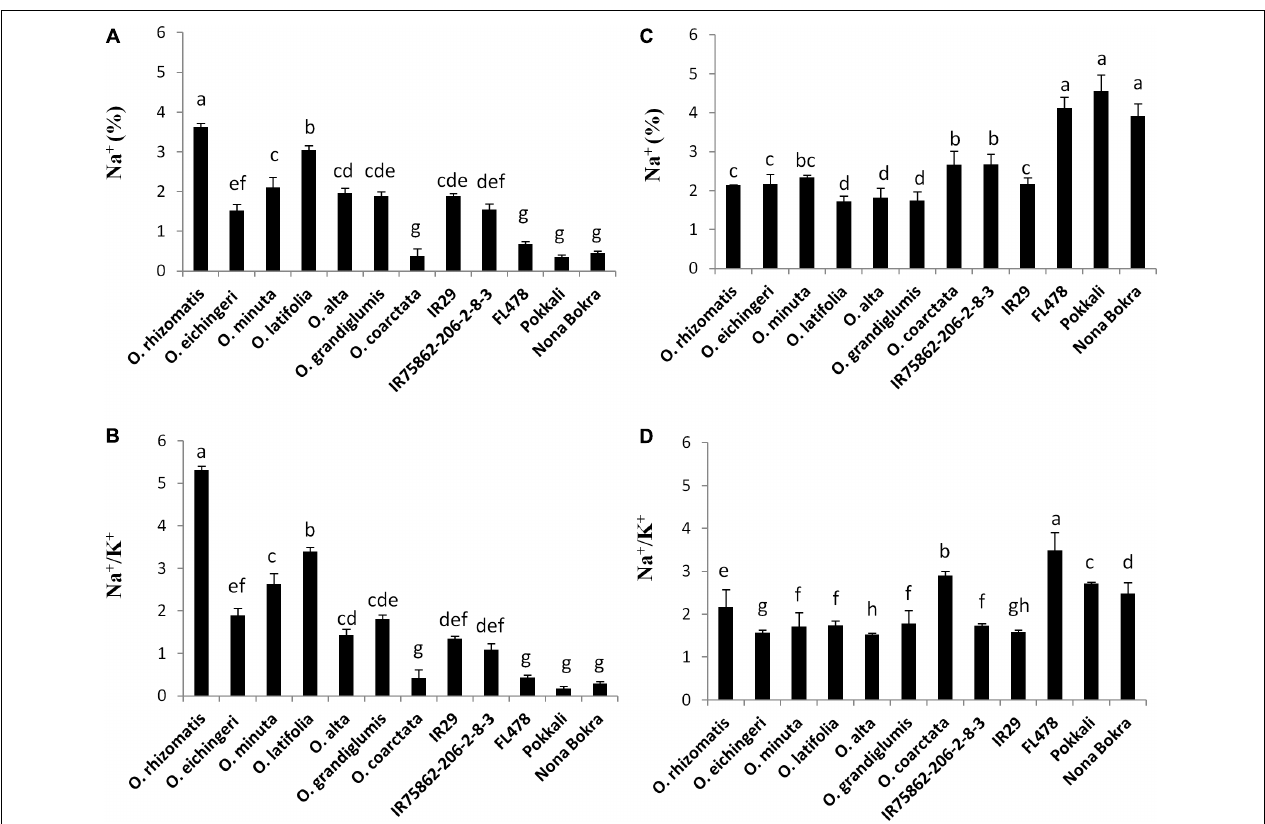
FIGURE 4 | Na + content (%) and Na + /K + ratio in shoot (A,B) and root (C,D) , respectively, in the tolerant wild species and the cultivated checks after 10 days of 180 mM NaCl treatment. Mean values were obtained from five plants. Vertical bars indicates ± SE. Different letters in error bars are statistically different as inferred from DMRT at p <